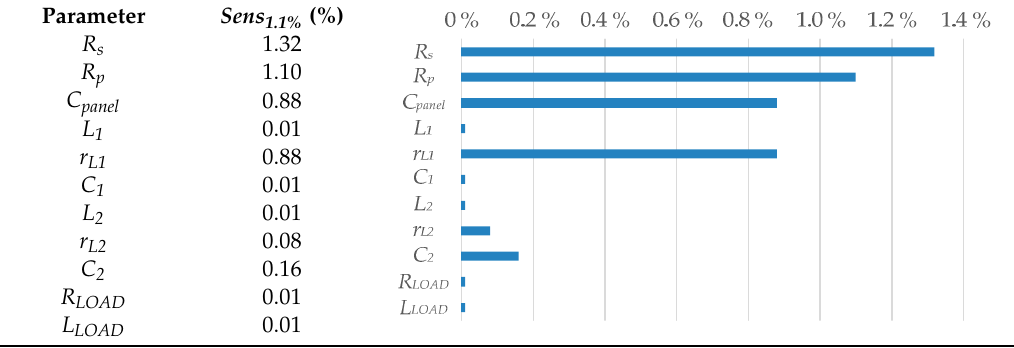
Table 9. Sensitivity in case of perturbation equal to 0.9 times the optimal parameter value. Parameter Sens 1.1% (%)